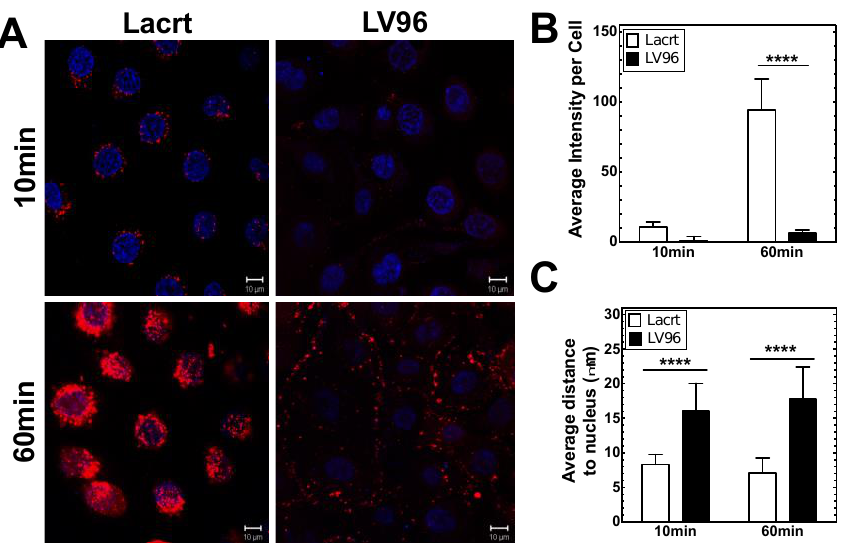
Figure 5. HCE-T cells associate with both recombinant Lacritin (Lacrt) and a Lacritin-V96 fusion (LV96). ( A ) Representative pictures showing live-HCE-T cell targeting and uptake of 10 µ M rhodamine-labeled lacritin (Lacrt) or LV96 over 1 h at 37 ◦ C in complete media. Red: rhodamine-labeled Lacrt or LV96; Blue: DAPI-stained nuclei. Bar = 10 µ m. ( B , C ) Image analysis was used to quantify ( B ) integrated intensity per cell and ( C ) average distance to the nucleus of LV96 vs. Lacrt. Mean ± SD, N = 9 measurements, **** p < 0.0001.